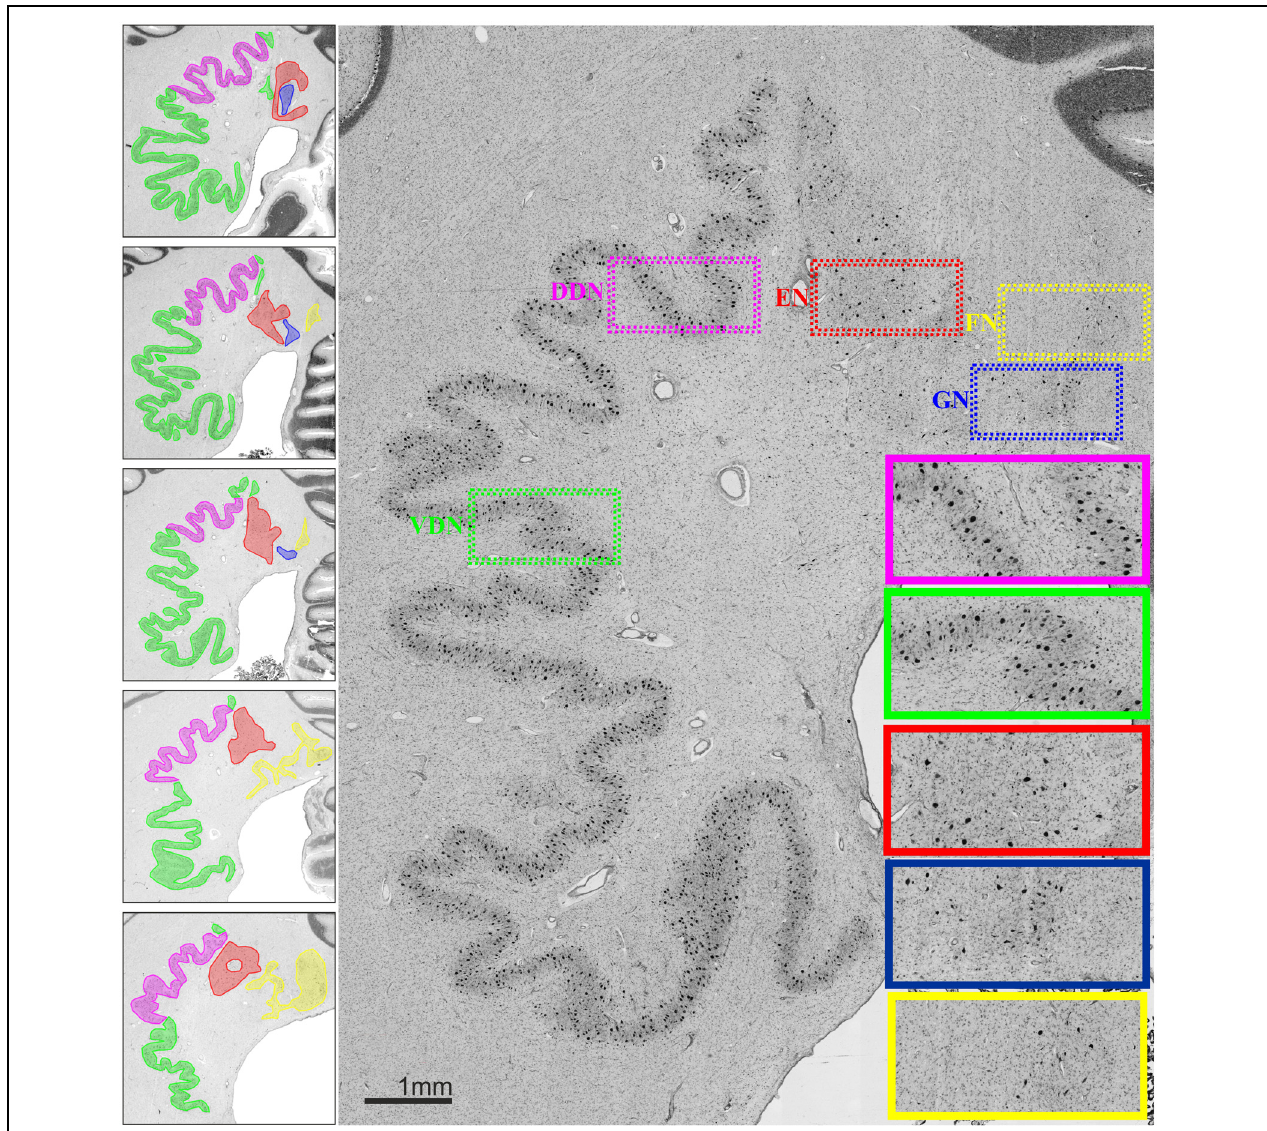
FIGURE 1 | (Left) Localization and extent of cerebellar nuclei in a rostro-caudal sequence of histological sections of a post mortem brain; distance between sections 60 µ m. (Right) Cytoarchitecture of each cerebellar nucleus and the